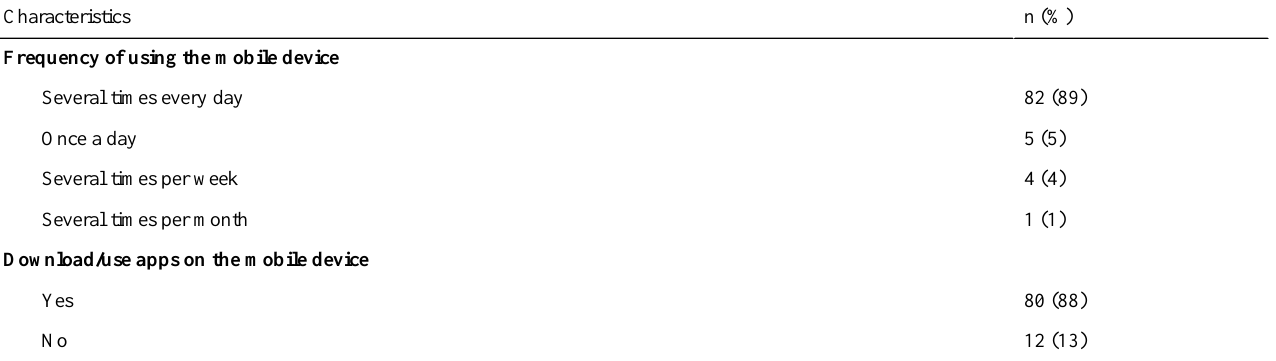
Table 2. Descriptive statistics: scale scores at enrollment for the Health-ITUES subscales (N=92).